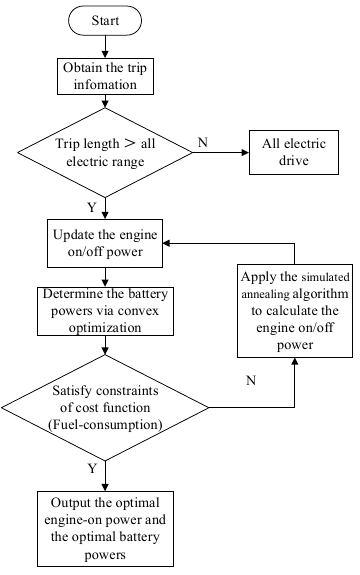
Figure 7. The whole optimization calculation process. SA: simulated annealing. In (18), the lower bound and upper bound on the engine ON/OFF threshold are set to P eng _ on _min and P eng _ on _max . Since the SA algorithm is insensitive to the initial value, the initial engine-on